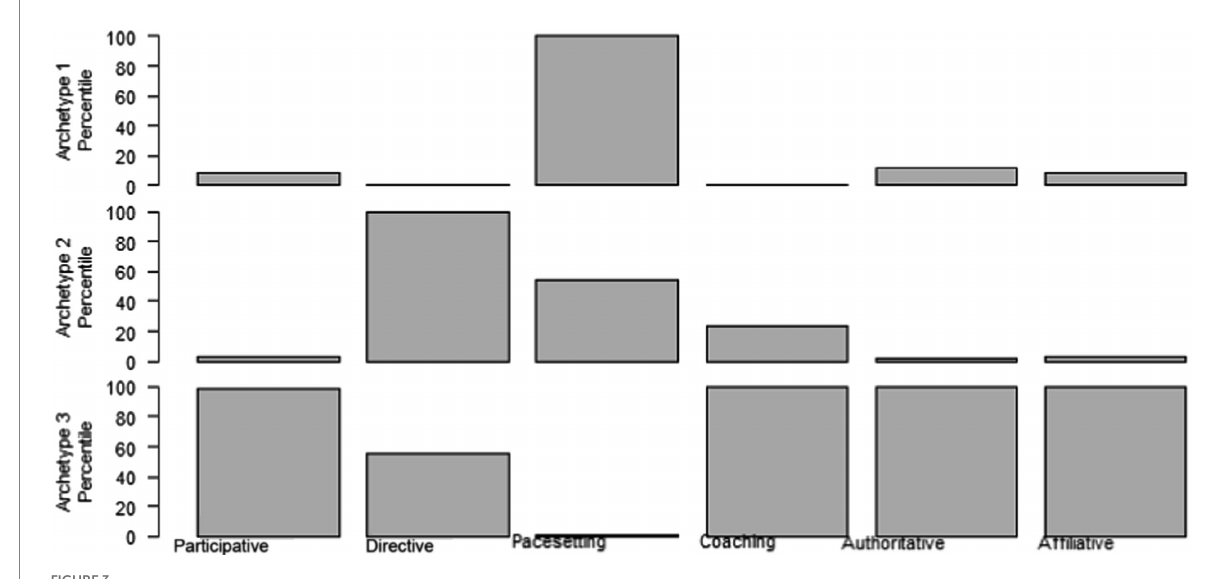
FIGURE 3 The relationship between the three archetypes and the six leadership styles.